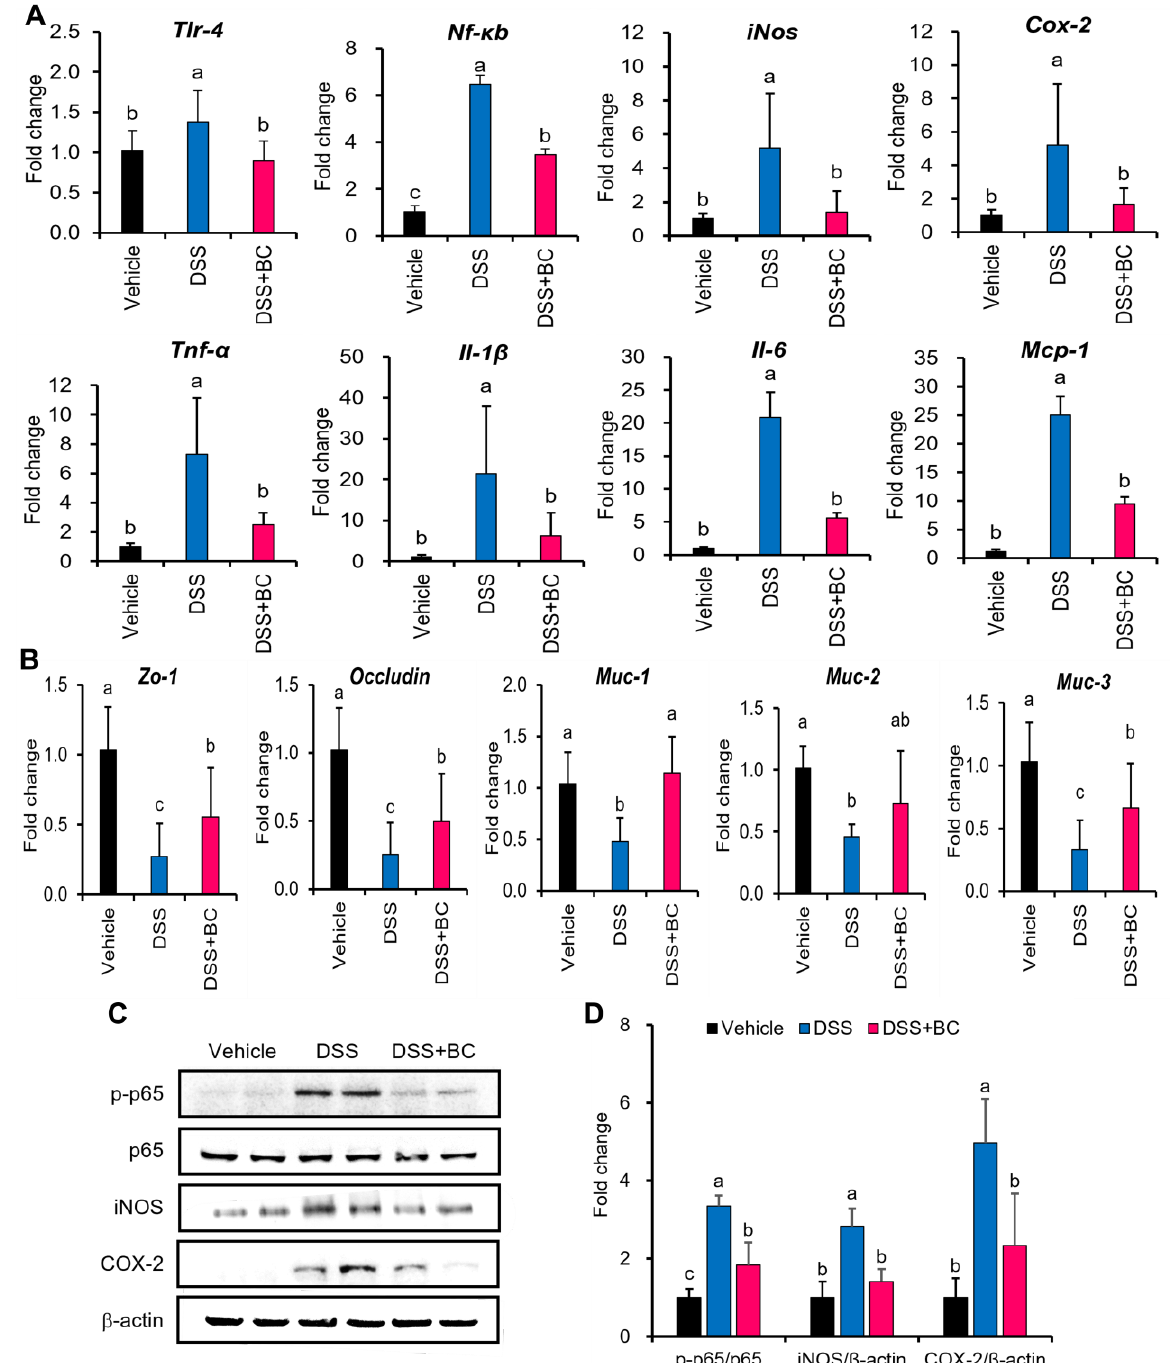
Figure 3. Effects of blackcurrant on the mRNA expression related to inflammatory factors, mucin, and tight junction protein, and the activation of the NF- κ B signaling pathway in DSS-induced colitis. ( A ) The relative levels of mRNA expression related to inflammatory factors ( Tlr-4 , Nf- κ b , iNOS , Cox-2, Tnf- α , Il-1 β , Il-6 , Mcp-1 ) in colon tissues; ( B ) the relative levels of mRNA expression related to tight junction protein ( Zo-1 , Occludin ) and mucin ( Muc-1 , Muc-2 , Muc-3 ) in colon tissues; ( C ) representative images and ( D ) quantitative results showing the expression levels of proteins (p-p65, p65, iNOS, COX-2) related to NF- κ B signaling pathway in colon tissue. The values are shown as mean ± SD (n = 8 per group). Distinct lowercase letters indicate significant differences between groups through one- way ANOVA and Duncan’s post hoc tests ( p < 0.05). Vehicle, normal control group not treated with DSS; DSS, DSS control group; DSS+BC; DSS + blackcurrant group.